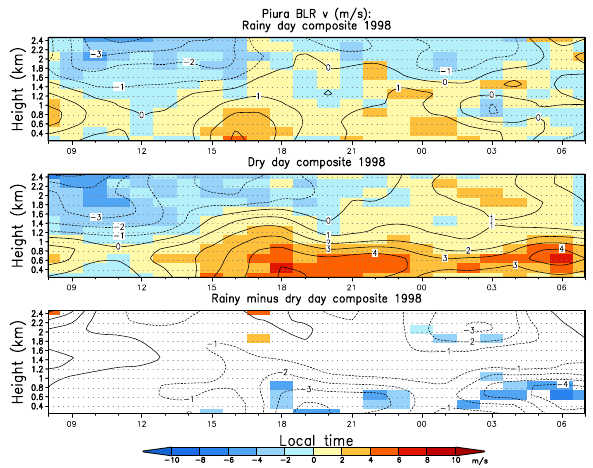
Fig. 7. Similar to Fig. 6 but for meridional wind.